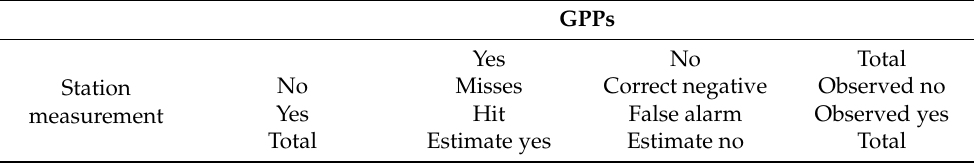
Table 2. Contingency table of ainy and non-rainy event prediction by global precipitation